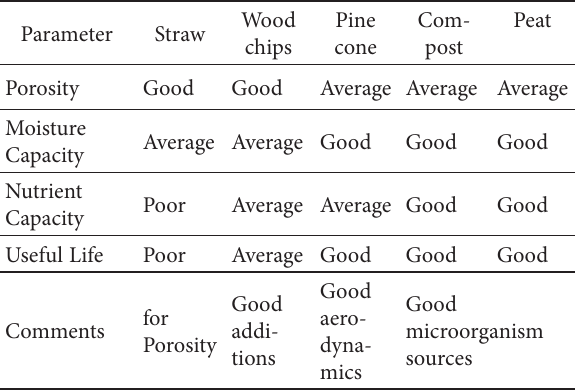
Table 6. Biofilter media characteristics